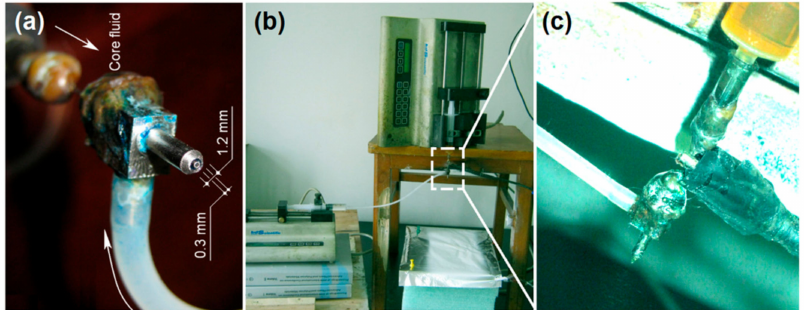
Figure 3. The apparatus used for modified coaxial electrospinning: ( a ) The home-made concentration spinneret; ( b ) the arrangement of apparatus; and ( c ) the connection of the power supply and working fluids with the